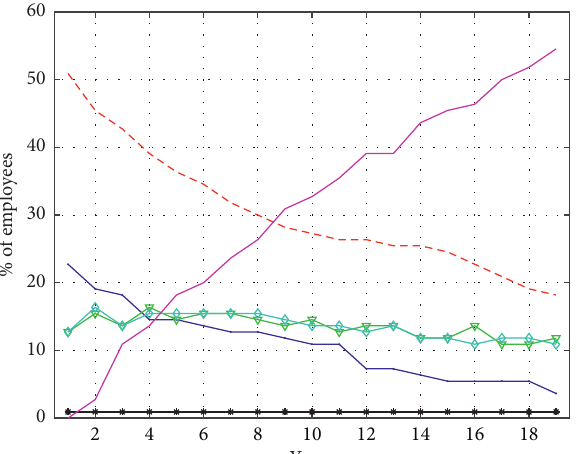
Figure 8: Percentage of employees with different behaviors during the simulation. The blue circle line represents the percentage of employees who are in set A, the red dashed line represents the ones in set B, and the black stair line represents the ones in set C who did not change set during the twenty years. The green triangle line represents the percentage of employees who during the twenty years worsened or not improved their rank position, whereas the cyan diamond line represents the ones who improved or not worsened. The magenta continuous line represents the percentage of employees who during the simulation time improved or worsened their position.